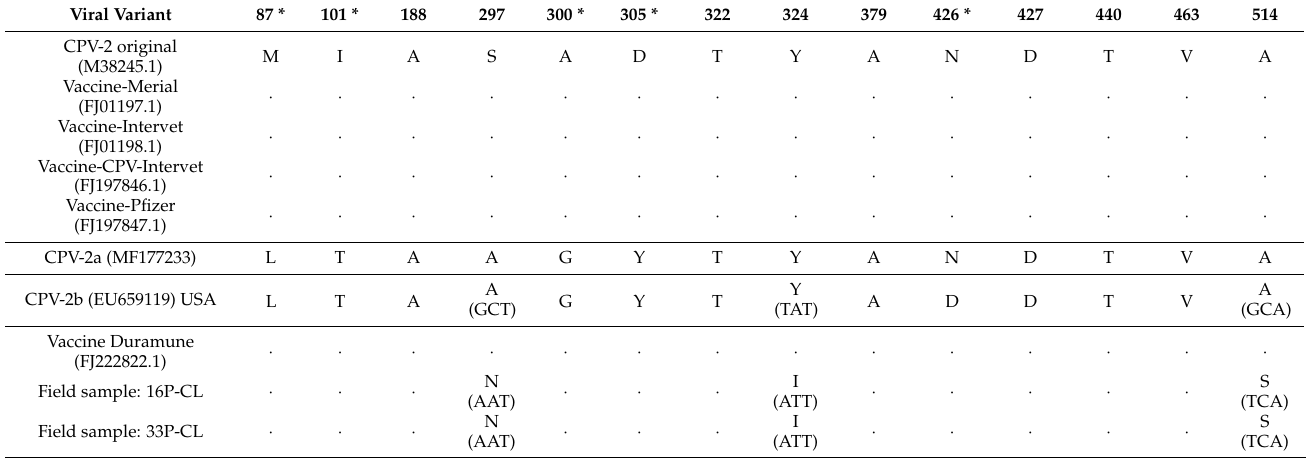
Table 1. Amino acid analysis of the VP2 protein in canine